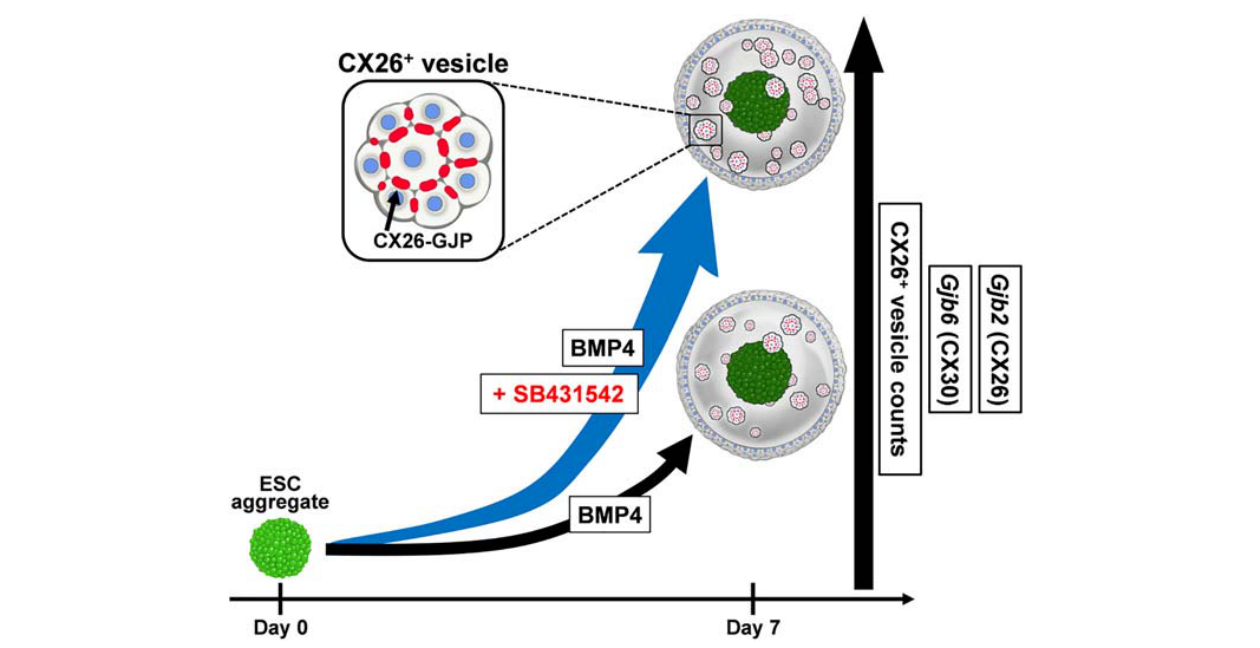
FIGURE 7 | A schematic illustration of the effect of SB431542 on CX26 GJ formation in BMP4-induced ESC differentiation. In the BMP4-based inner-ear three-dimensional differentiation from ESCs, addition of SB431542 was associated with significantly higher mRNA levels of Gjb2 (CX26) and Gjb6 (CX30) and CX26 + vesicle counts relative to cultures without the addition of SB431542. SB431542 was demonstrated to be an accelerator of GJ